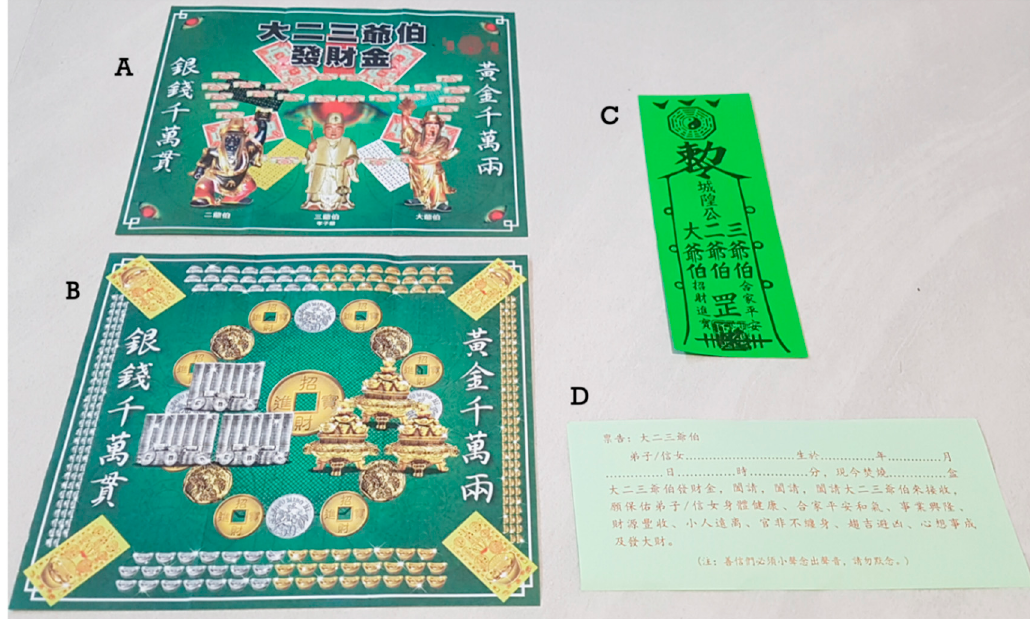
Figure 5. Contents inside a box of “Prosperity Money” (Source: Author). ( A ) is the front of the “Prosperity Money” incense paper featuring statues of the trio and embellished with motifs of hell notes, while ( B ) is the back of the “Prosperity Money” filled with pictures of golden and silver coins, ingots, and treasure urns. The couplet (printed in white font) on both sides of the “Prosperity Money” translates as “ten million taels of golden ingots and ten million strings of silver coins.” Along with the incense paper is a talisman ( C ) bearing the names of the City God and the three Grand Uncles, which is required to be burnt together with the “Prosperity Money,” thereby directing these incense paper to the respective gods. Lastly, a memorandum ( D ) is included in the package to guide the person making the o ff ering on the proper procedure with a verse to